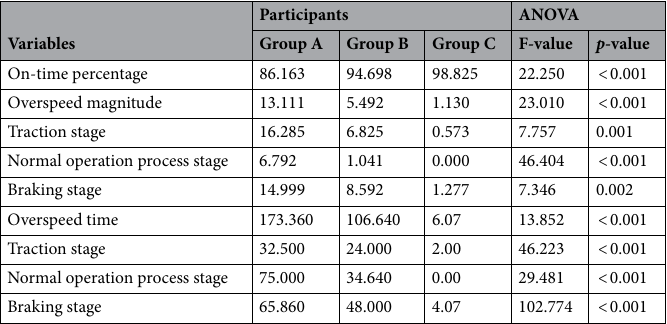
Table 1. Impact of driving experience on driving performance.